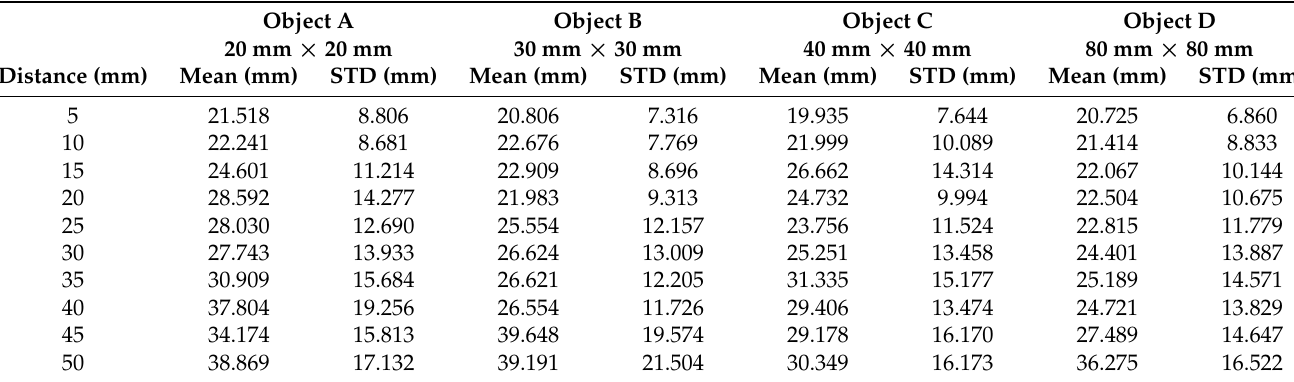
Table 2. PE data for experimental data and simulation data.